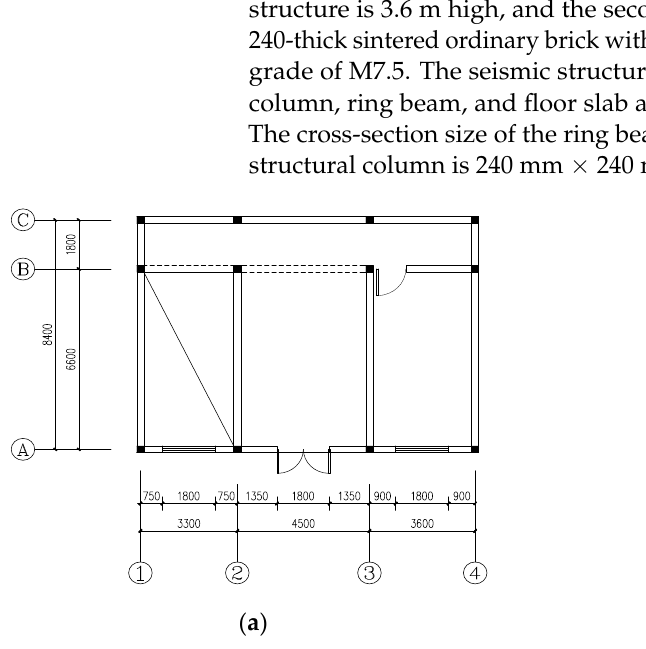
Figure 8. Layout and perform ‐ 3D model of a two ‐ story brick ‐ concrete structure. ( a ) Layout (unit: mm); ( b ) Perform ‐ 3D